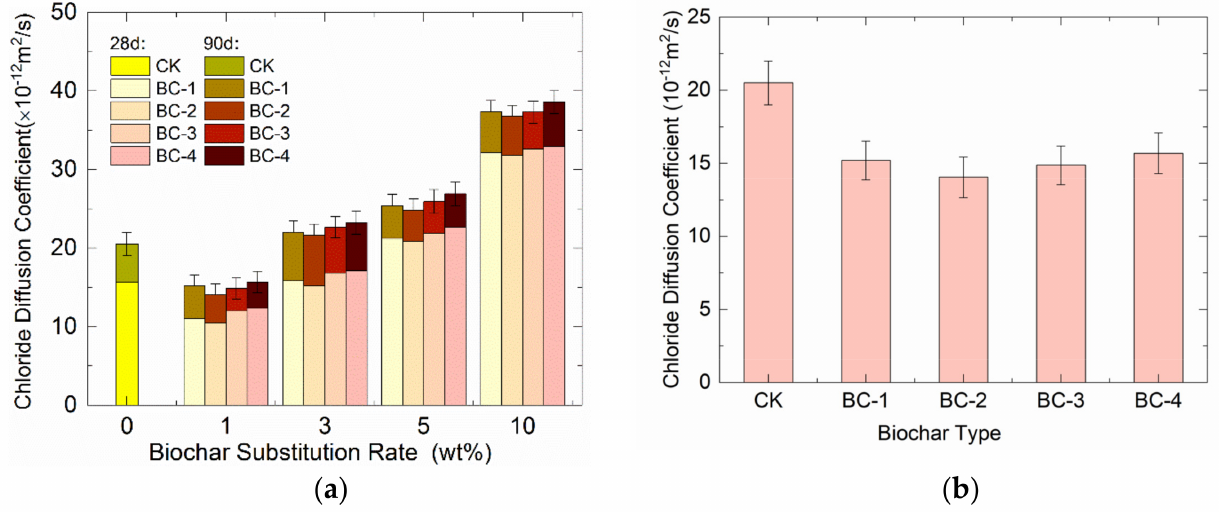
Figure 5. Relationship between ( a ) biochar dosage and chloride diffusion coefficient; and ( b ) the chloride ion diffusion coefficient of biochar concrete and different fineness at 1%